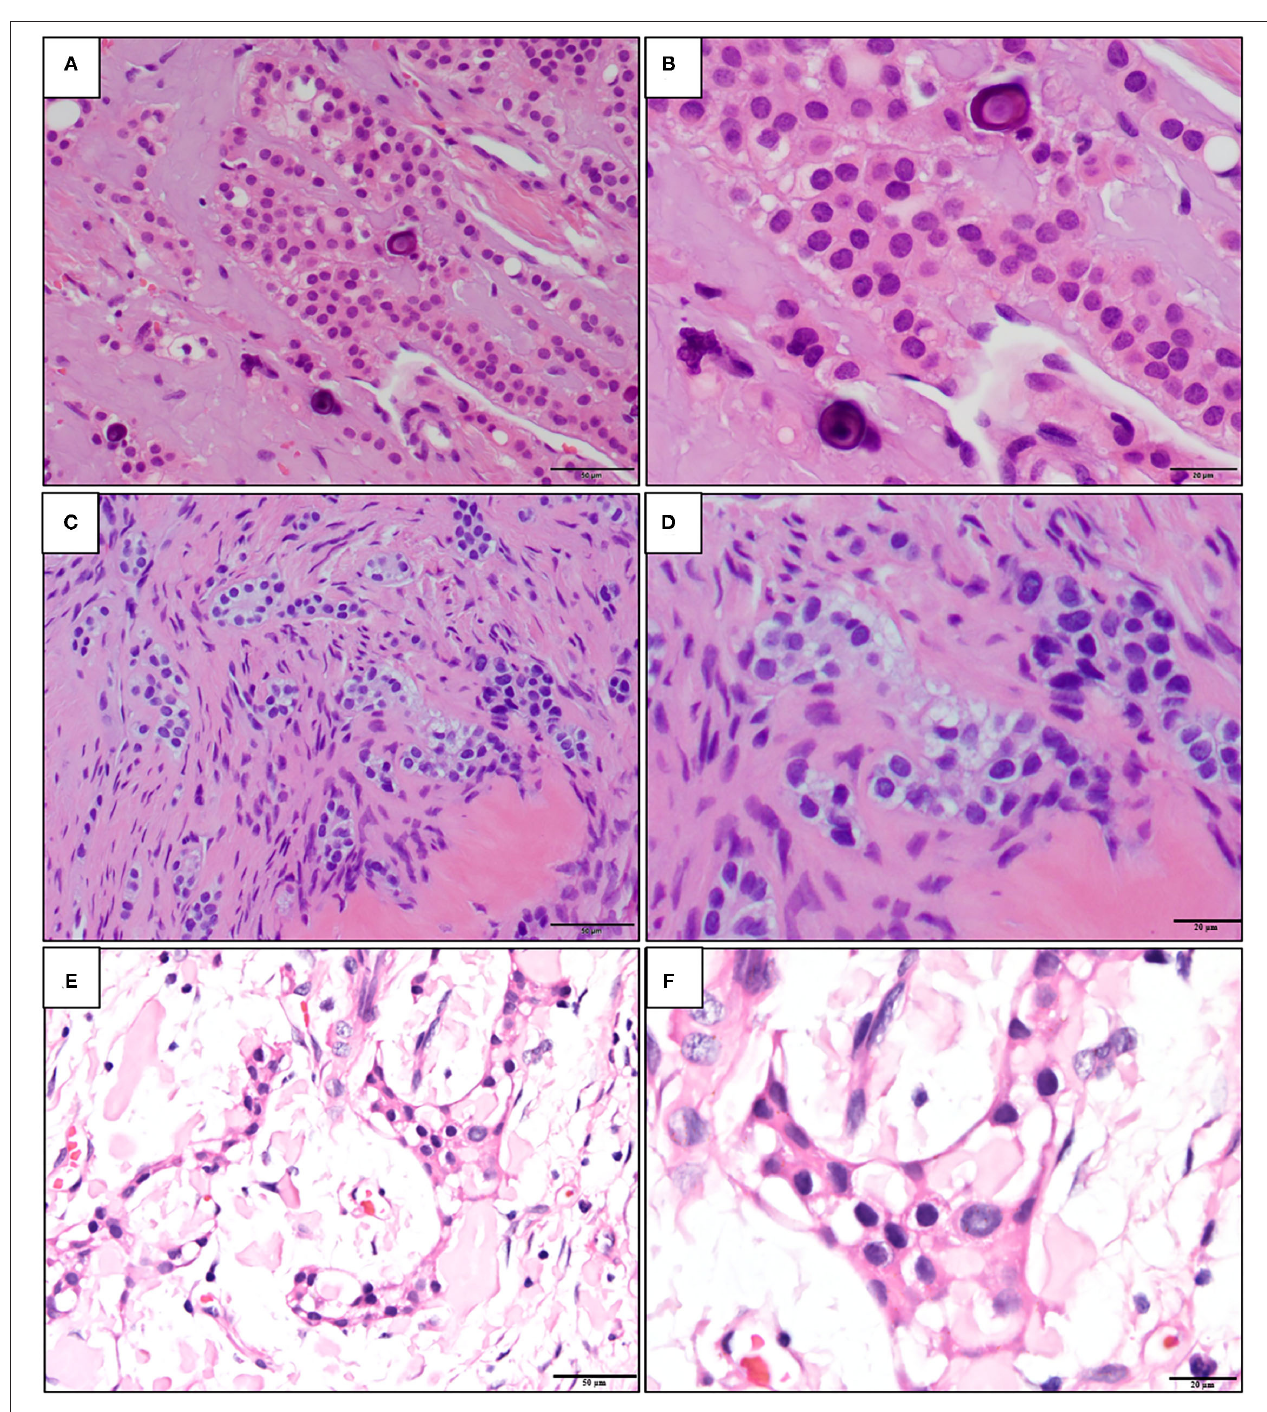
FIGURE 1 | The representative histopathological photographs of (A,B) classic calcifying epithelial odontogenic tumor (CEOT); (C,D) central odontogenic fibroma (COF); and (E,F) non-calcifying, Langerhans cell rich CEOT (NCLC-CEOT) [Hematoxylin and eosin (H&E); A,C,E : 200 × ; B,D,F : 400 ×